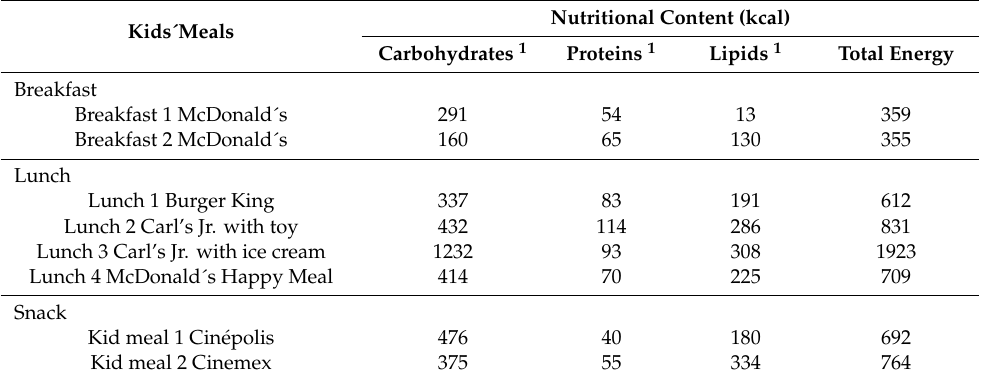
Table 2. Bromatological results for energy and macronutrient content of kids’ meals.